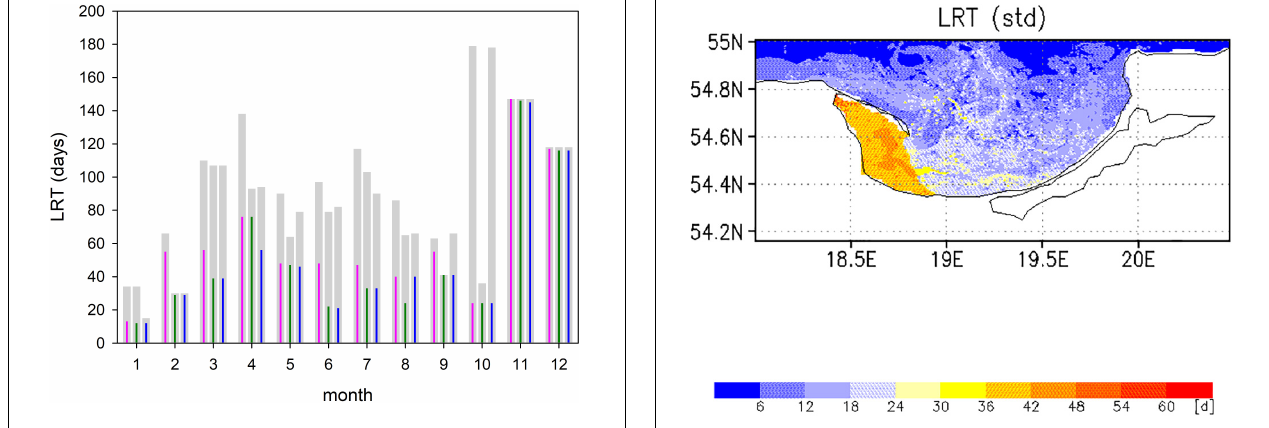
FIGURE 8 | Amount of time required for all tracers (T 100 , gray bars) and 95% of the tracers (T 95 , colored impulse) to leave the Bay of Gda´nsk. The time is computed for each month and different diffusion velocities P = 0 m/s (magenta); P = 0.1 m/s (green), and P = 0.2 m/s (blue).